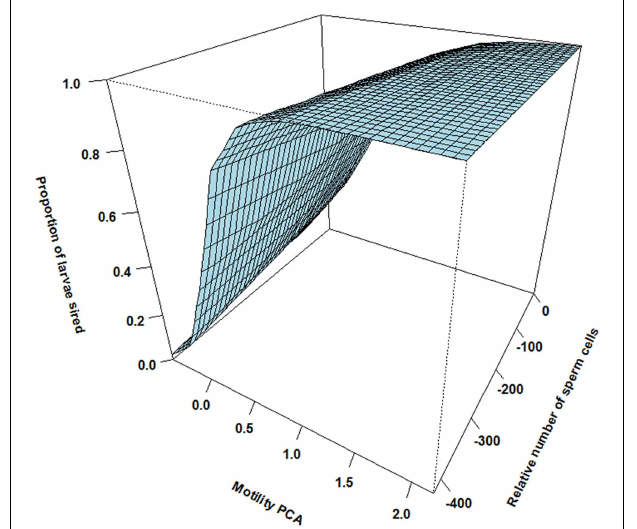
FIGURE 4 | The effect of relative motility PCA (i.e., per cent motile sperm cells and sperm velocity in ovarian fluid) and relative number of sperm cells on proportion of larvae sired for subdominant males ejaculating after the competing dominant male (asynchrony). Here, the effect of increased motility and increased sperm numbers is